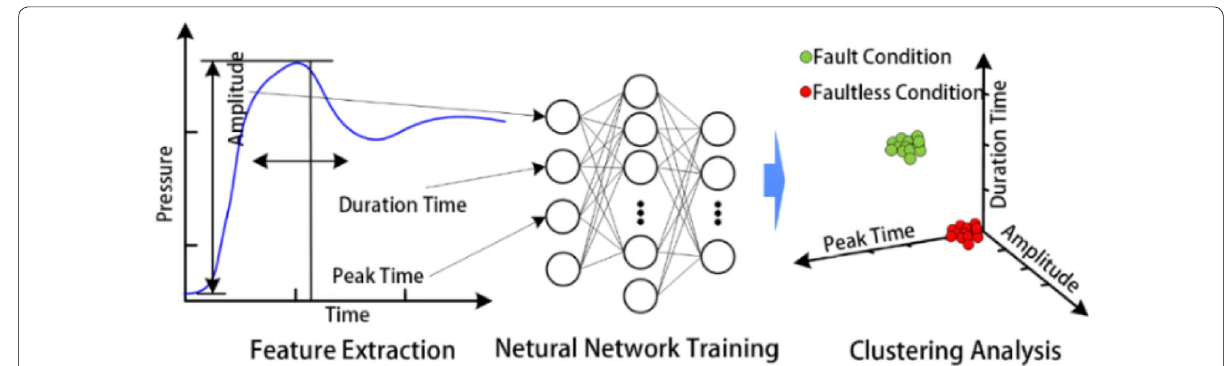
Figure 20 Fault feature selection and the clustering schematic diagram [94, 95]